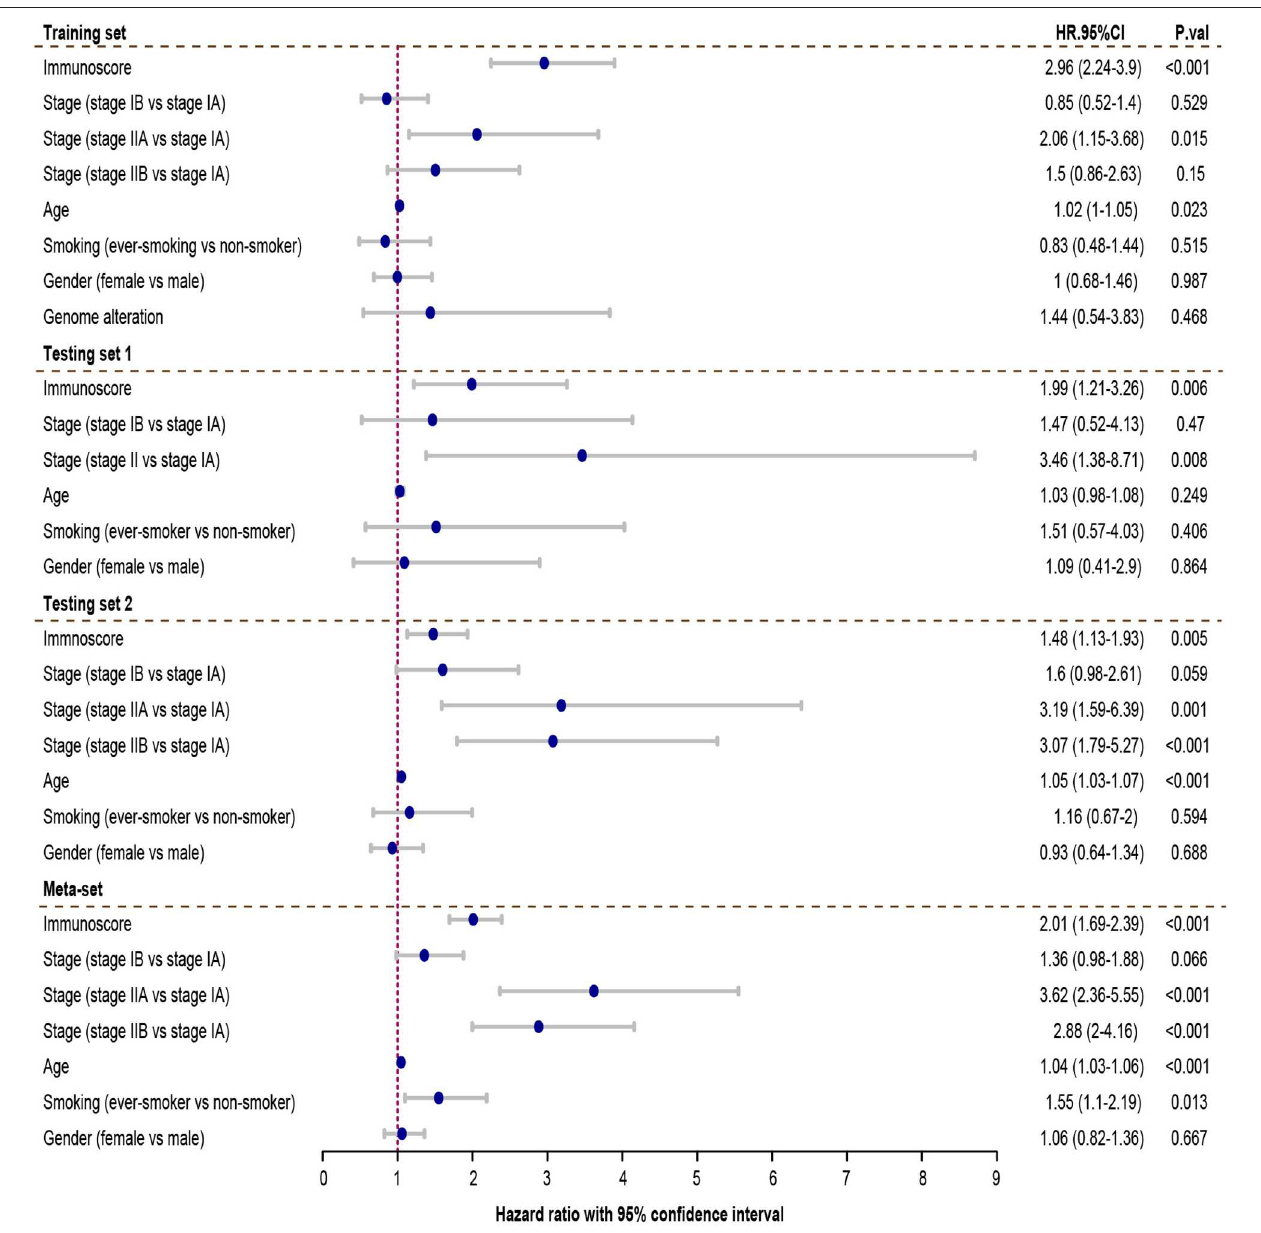
FIGURE 5 | Multivariate Cox analysis evaluating independently predictive ability of immunoscore for patient survival. The immunoscore was able to independently predict patient survival in training set (hazard ratio (HR) = 2.96, 95% confidence interval (CI) from 2.24 to 3.9, P < 0.001), testing set 1 (HR = 1.99, 95% CI from 1.05 to 3.81, P = 0.006), testing set 2 (HR = 1.48, 95% CI from 1.13 to 1.93, P = 0.005), and meta-set (HR = 2.01, 95% CI from 1.69 to 2.39, P < 0.001). HR.95%CI, hazard ratio with 95% confidence